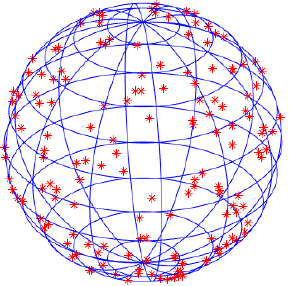
Figure 16. Distribution of infrared star source.